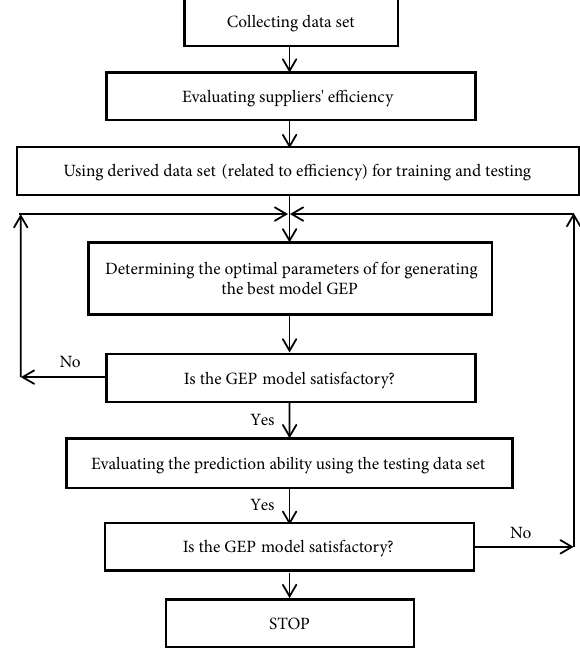
Fig. 4. The hybrid model for supplier